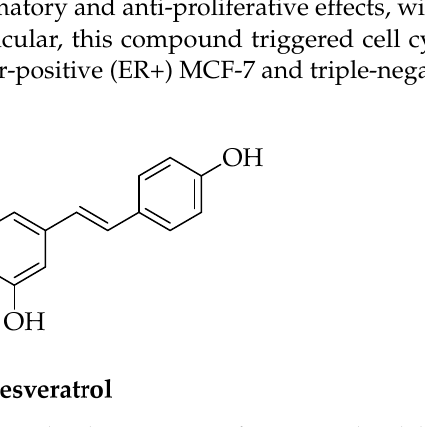
Figure 1. Molecular structures of Resveratrol and derivative 2 .